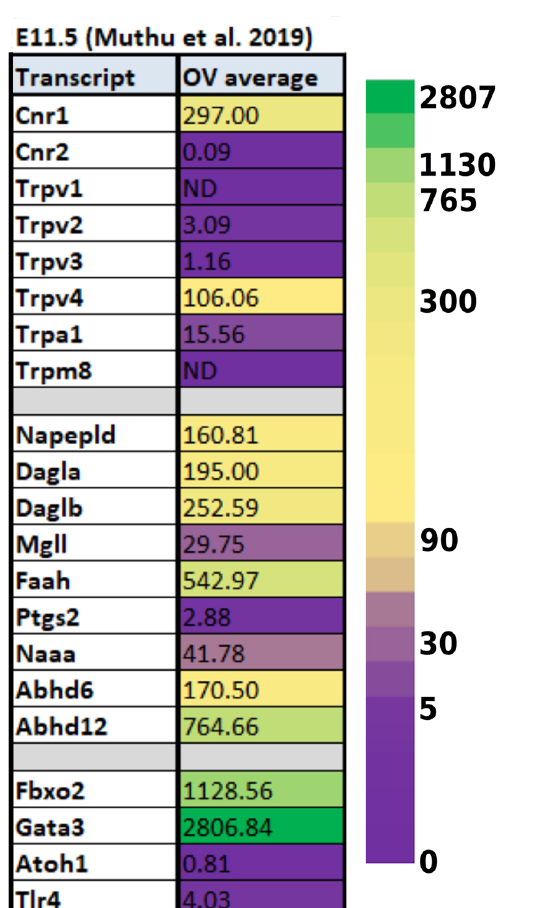
TABLE 2 | Expression of ECS-related transcripts from reported RNA-seq values using E11.5 otic vesicles. Data from E11.5 embryos were obtained from Muthu et al. (2019) and is presented as reads per kilobase million (RPKM). The last four rows demonstrate values obtained for transcripts known to be